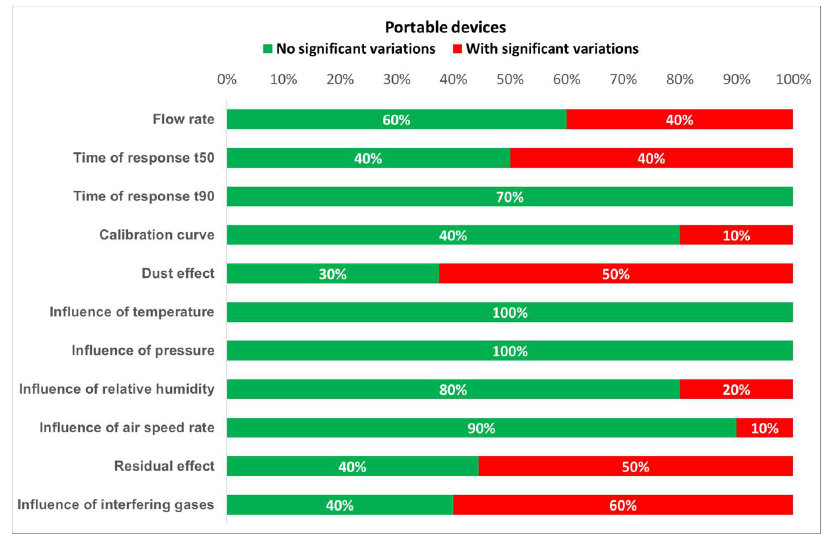
Figure 17. Detected variations for portable devices.